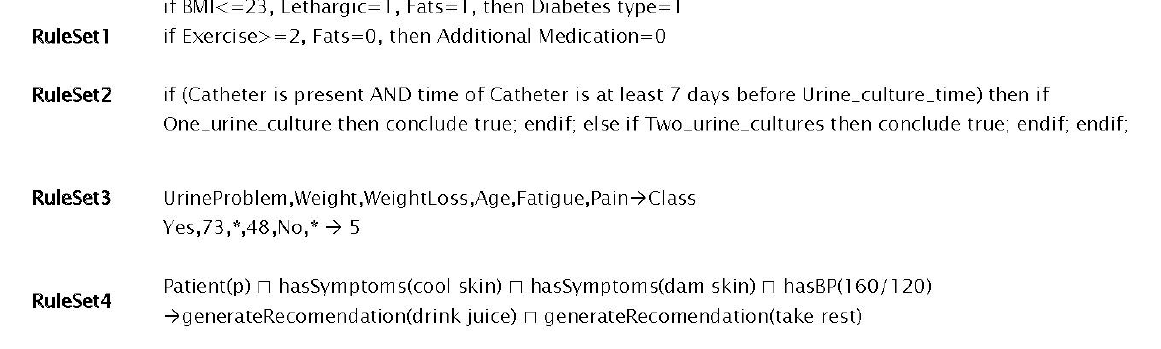
Figure 5. Examples of procedural (if…then) rules, rule in arden syntax (only logic part), comma separated rule used by Rough Set, and description logic rule.